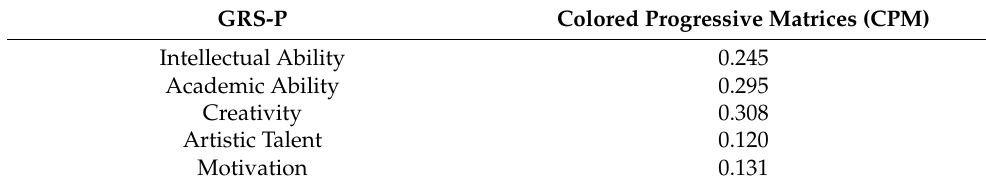
Table 5. Correlations between GRS-P and colored progressive matrices test (CPM).